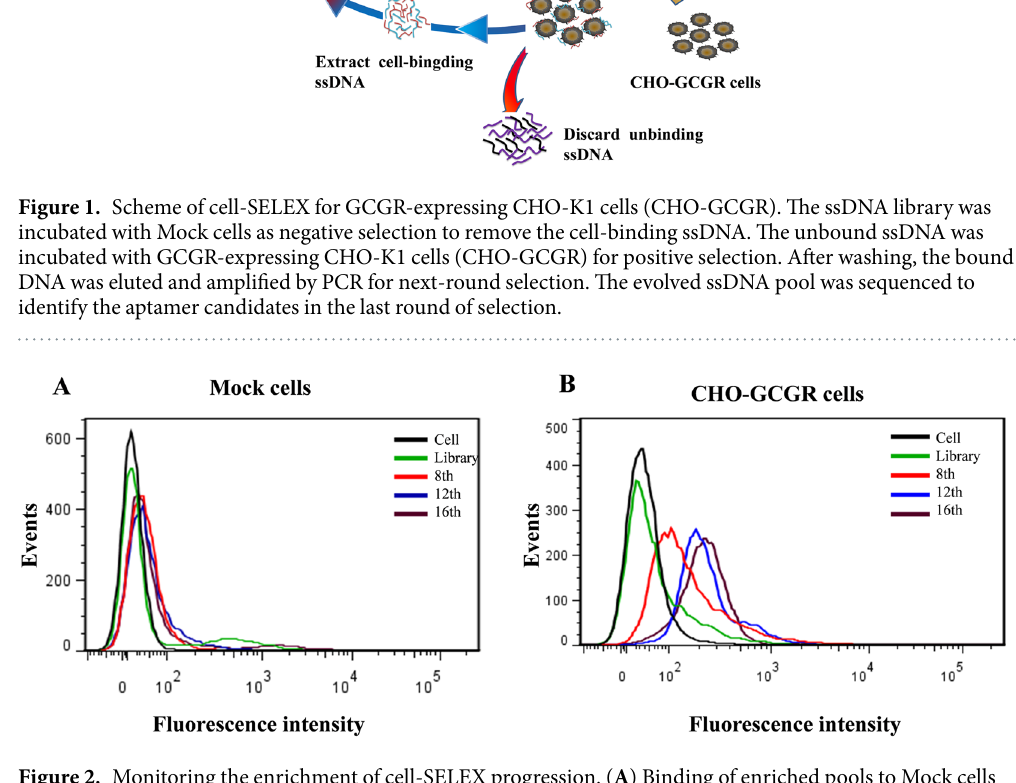
Figure 2. Monitoring the enrichment of cell-SELEX progression. ( A ) Binding of enriched pools to Mock cells (control cells) and ( B ) CHO-GCGR cells (target cells) from the 8th, 12th and 16th rounds were monitored by flow cytometry assay. The unselected initial ssDNA library was used as negative